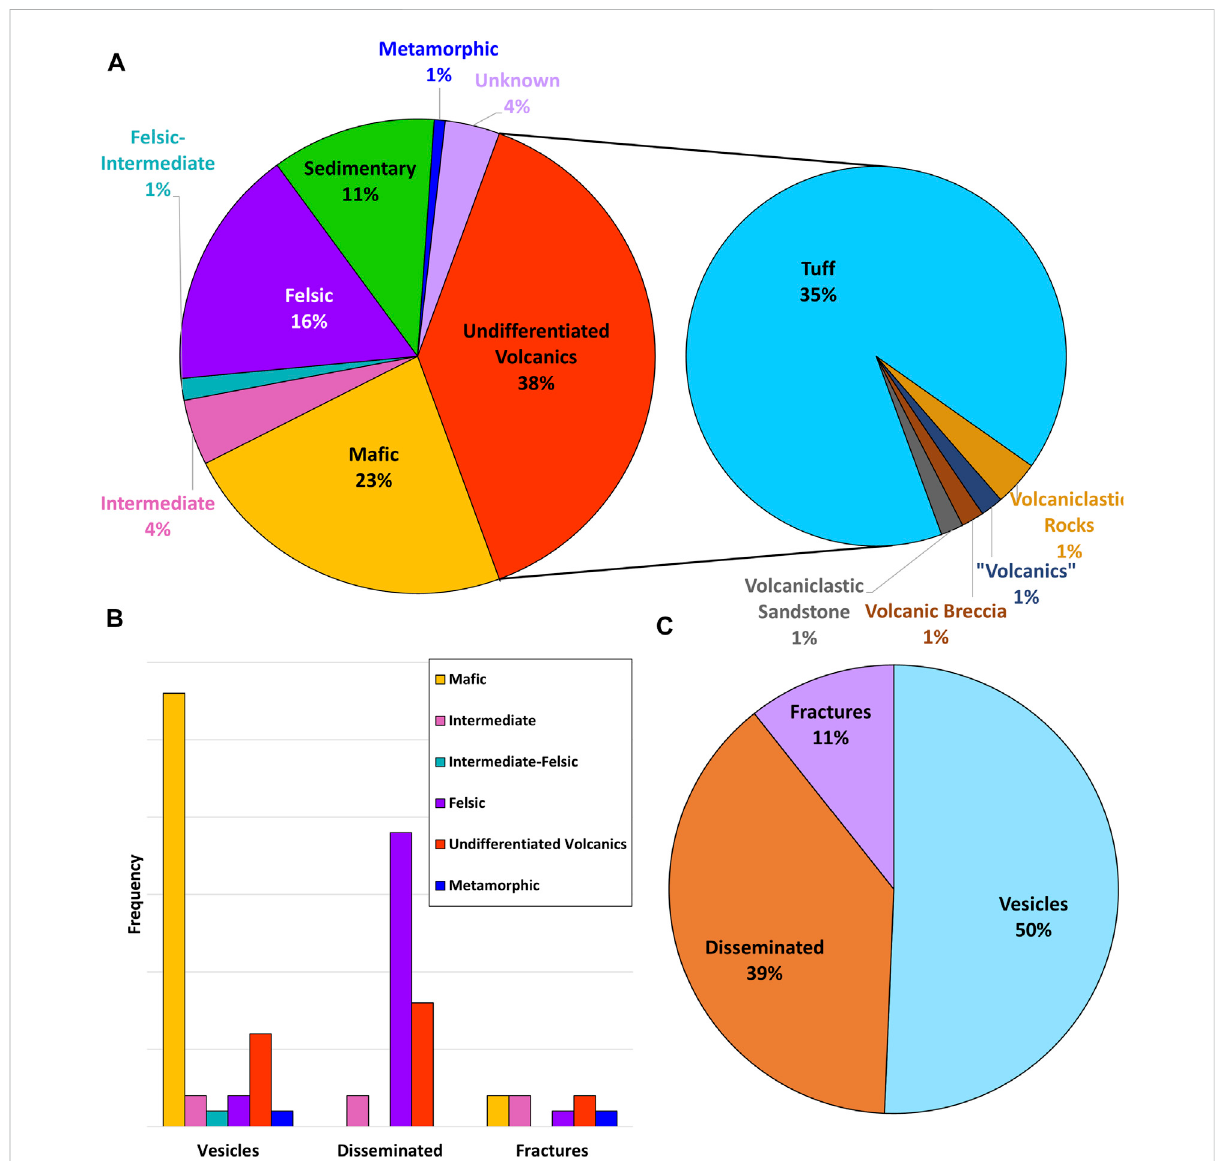
FIGURE 4 Propertiesoferionitebearingrock. (A) Rocktypeserionitehasbeenfoundin(oftentufftypeisnotdifferentiatedwithintheliterature); (B) where erionite is found within the rocks; (C) overall proportions of erionite reported from vesicles, fractures, and disseminated within the rock mass (note: vesicles refer to vesicles, vugs, and amygdules; disseminated refers to matrix; fractures includes both veins and